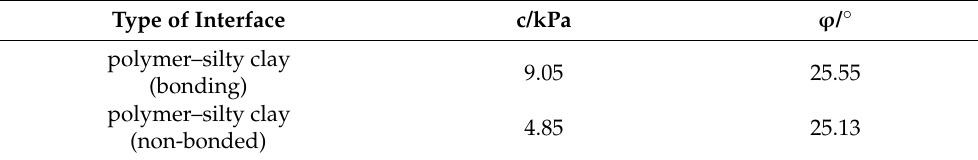
Figure 7. Shear stress–shear displacement curves of different interface bonding states. Table 6. Shear strength indexes of interfaces in different bonding states.